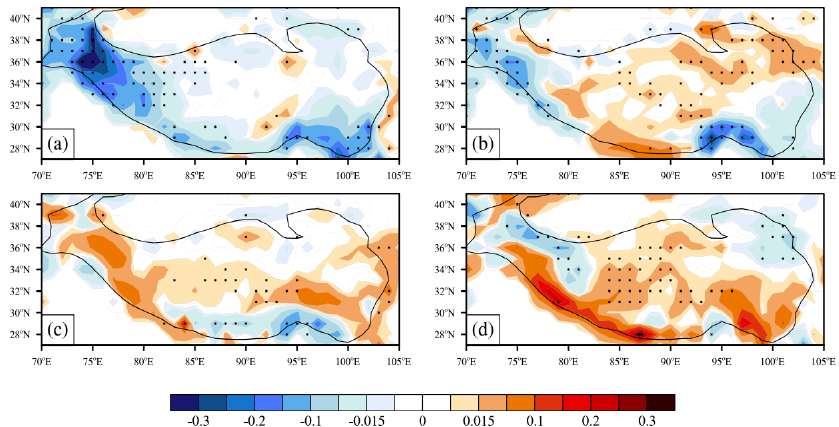
Figure 5. Trends (units: N m − 2 decade − 1 ) of the SWMF over the TP during 1979–2017 in different seasons ( a ) spring (March–May), ( b ) summer (June–August), ( c ) autumn (September–November), and ( d ) winter (December–February). The black contour denotes the isoline of 3000 ‐ m elevation. The dots indicate significant trends at 95% confidence level using the student ‐ t test.